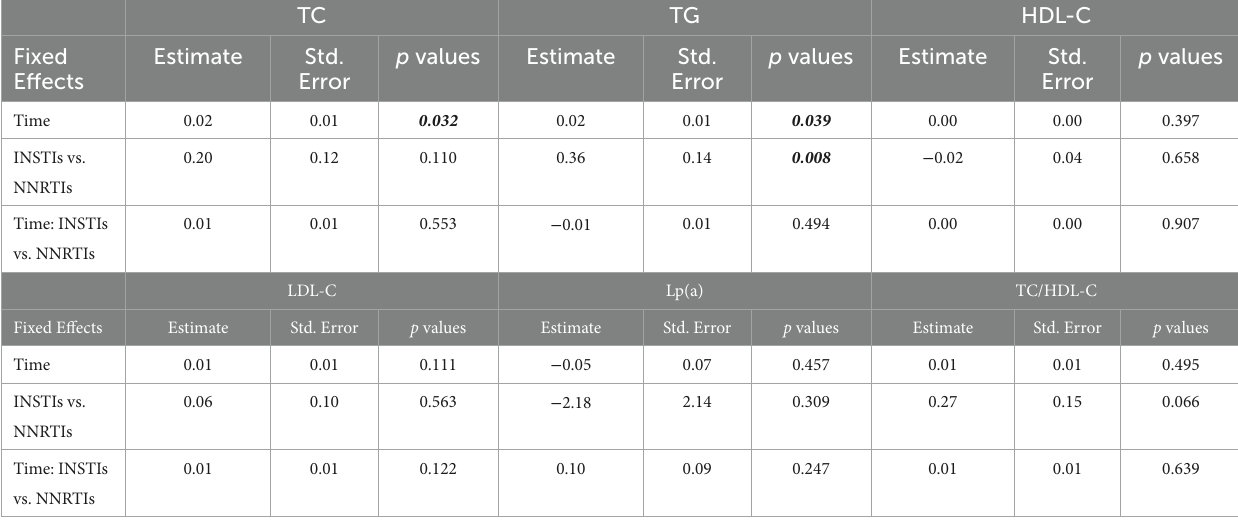
TABLE 4 Estimates of the generalized linear mixed-effects model (GLMM) for lipidemia over time.